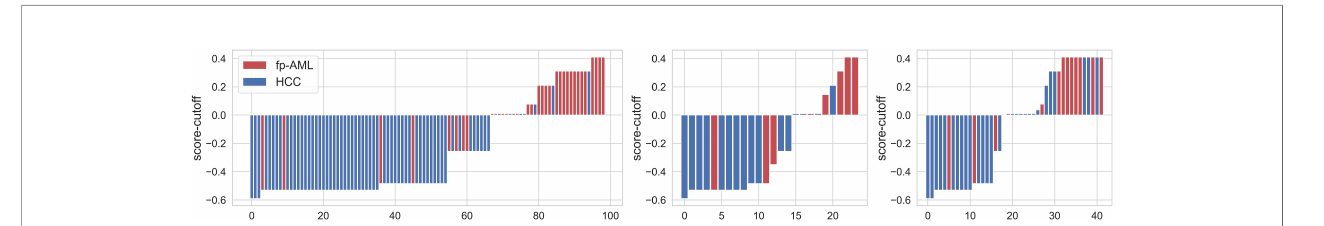
FIGURE 5 | The calibrated radiomics scores for each patient in the training, internal validation, and external validation cohorts. The red bars represent the scores for fat-poor angiomyolipoma patients, while the blue bars represent the scores for the hepatocellular carcinoma patients.